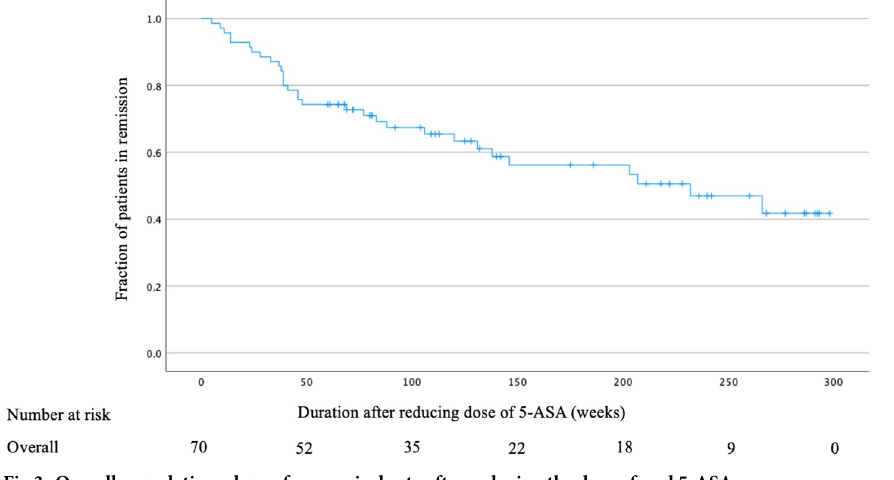
Fig 3. Overall cumulative relapse-free survival rate after reducing the dose of oral